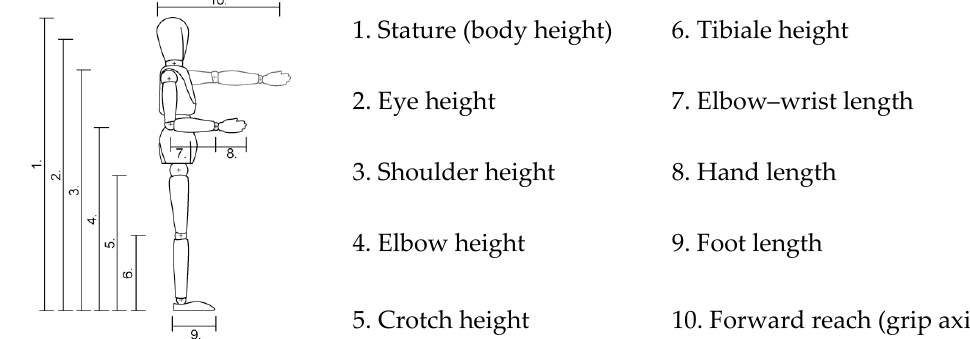
Figure 3. The ten measurements considered to represent the human figure in the present study. Based on Jurgens et al. [37] dataset (in which the anthropometric measurements of male and female individuals were considered together), the human figure is represented through a sexless manikin.